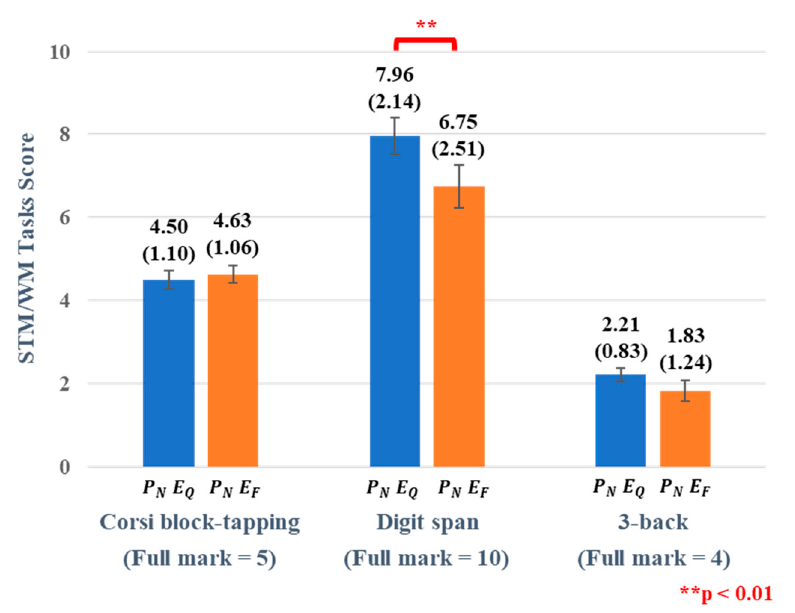
Figure 4. The mean and standard deviation values of STM/WM tasks for each experimental condition.